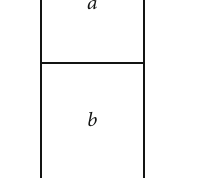
Figure 1: The structural mechanics model of coal-rock combination: (a) geological engineering model; (b) simpli fi ed model.